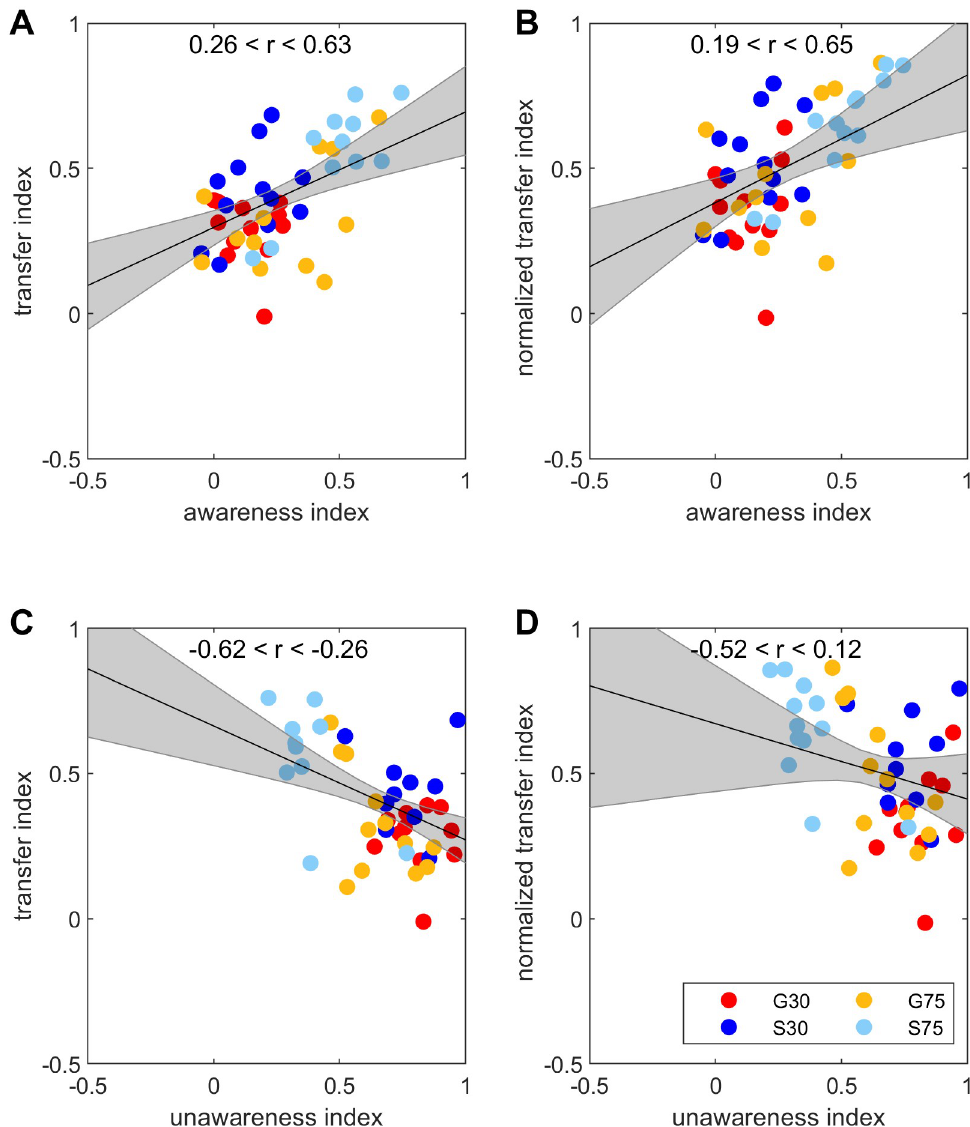
Fig 6. Correlations between awareness, unawareness, intermanual transfer and normalized intermanual transfer. Correlations between the awareness and transfer (A) or normalized transfer (B) indices as well as correlations between the unawareness and transfer (C) and normalized transfer (D) indices for all